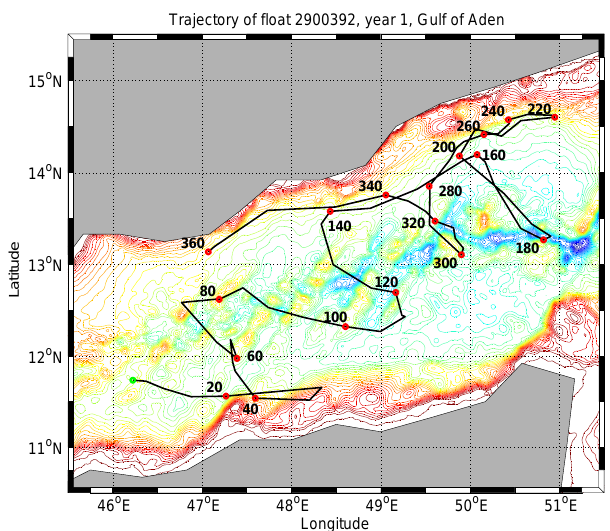
Fig. 6. Trajectory of float 2900392 in the Gulf of Aden, superim- Figure 6: Trajectory of float 2900392 in the Gulf of Aden, superimposed on bathymetry, posed on bathymetry, year 1; the green dot is the starting point of year 1; the green dot is the starting point of the trajectory; positions every 20 days are indicated by a red dot. the trajectory; positions every 20 days are indicated by a red